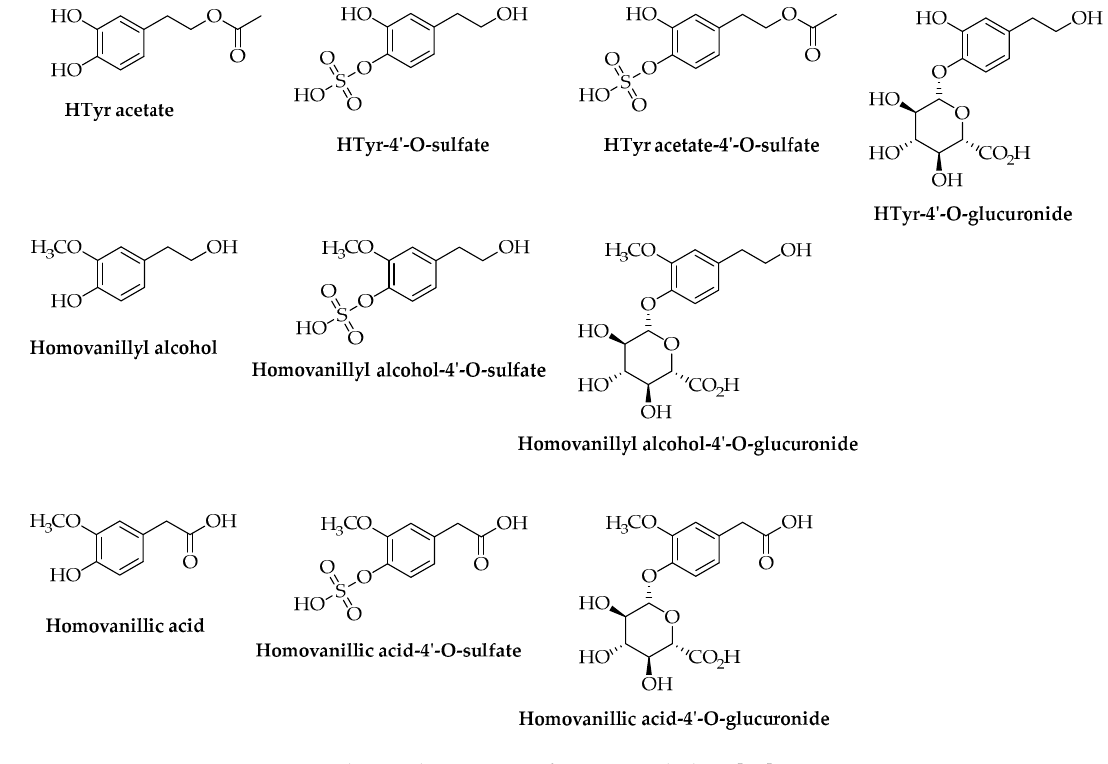
Figure 2. Chemical structures of HTyr metabolites [43].